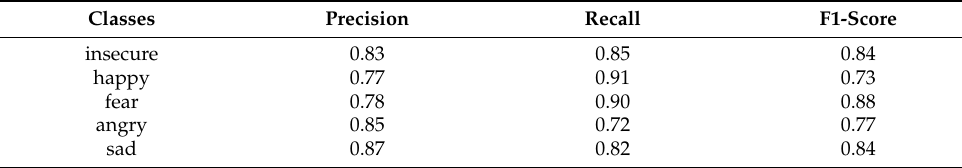
Table 2. MobileNet Classification Report.